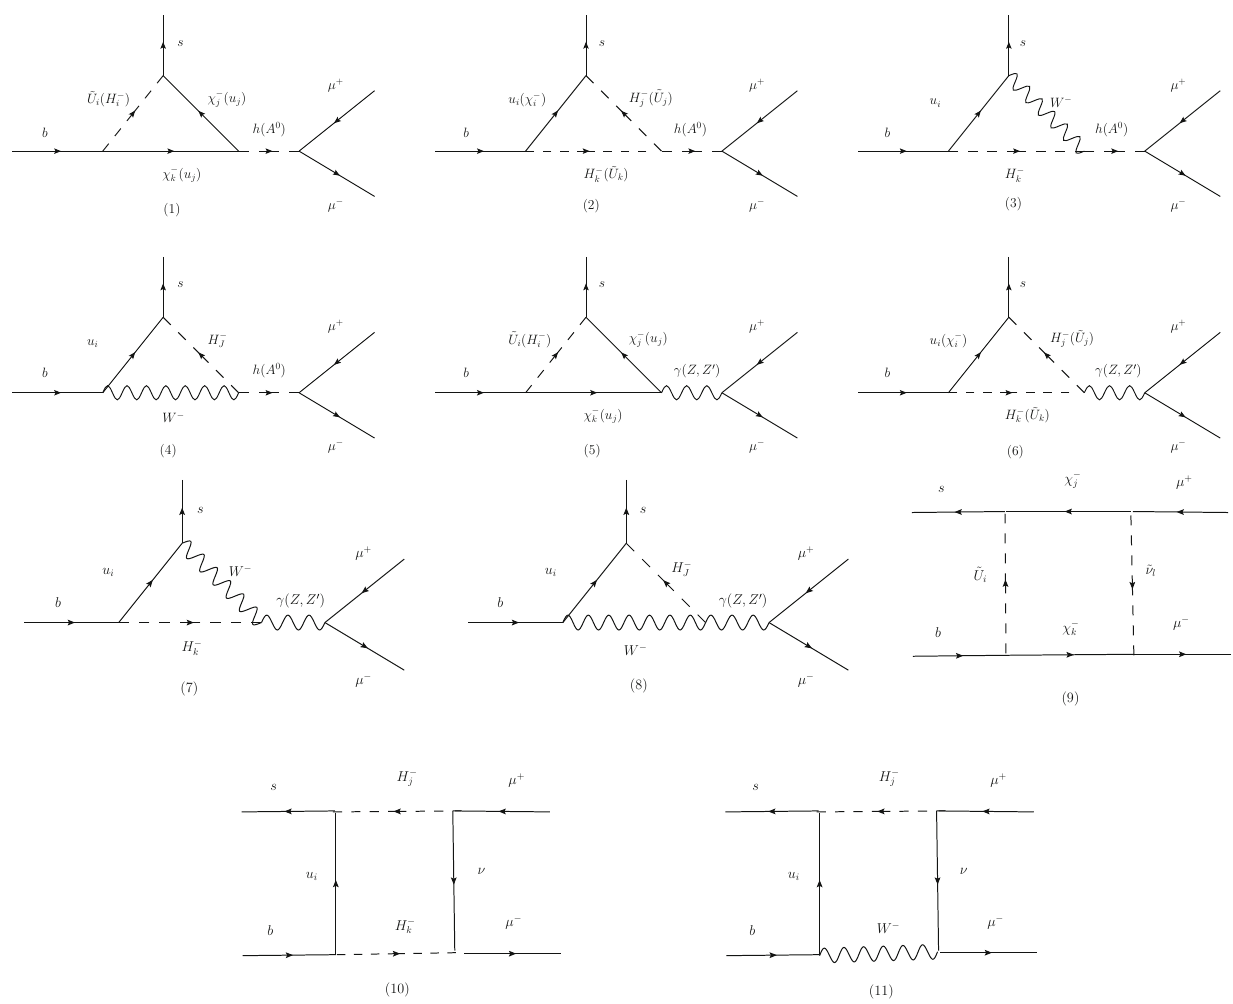
Fig. 4 The Feynman diagrams contributing to the decay B 0 s → μ + μ − in the